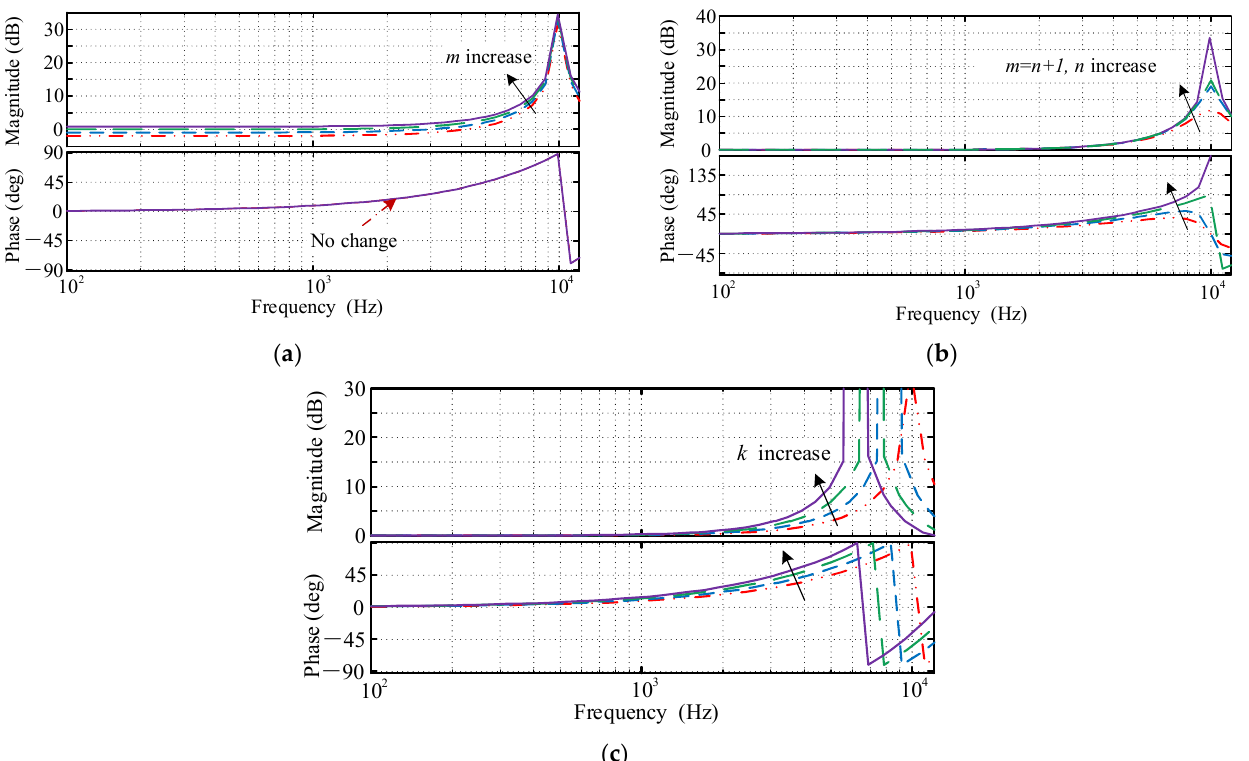
Figure 5. Bode diagrams of first-order lead link under different coefficient changes: ( a ) Bode diagrams of first-order leading